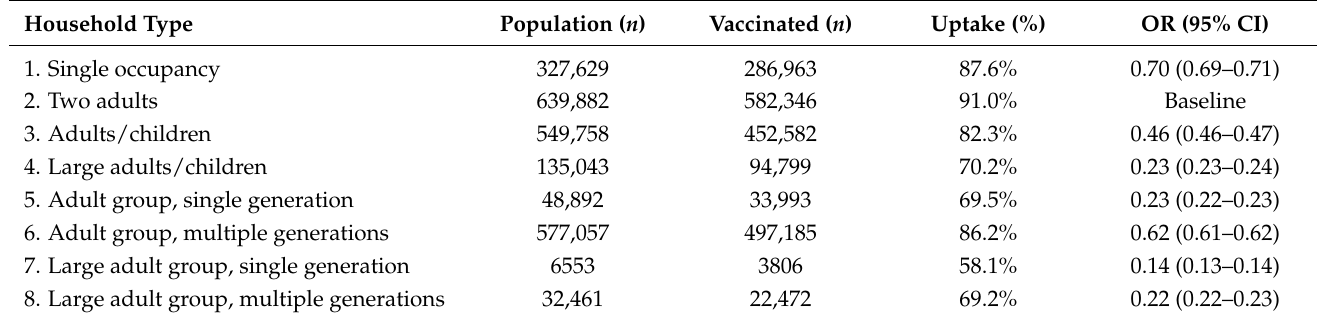
Table 2. Uptake of two doses of COVID-19 vaccine (any type) by household type and odds of being vaccinated, Wales a .